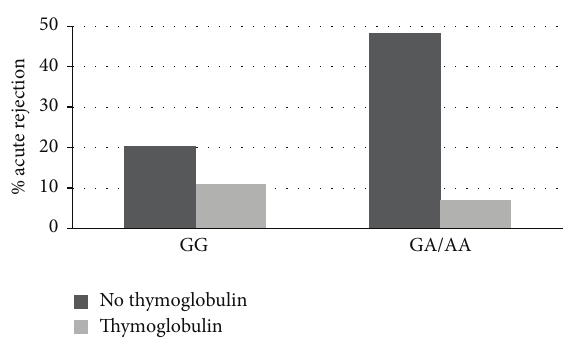
Figure 2: Percentage of AR in renal transplant patients stratified both − 308G/A TNF- 𝛼 gene polymorphism and treatment with